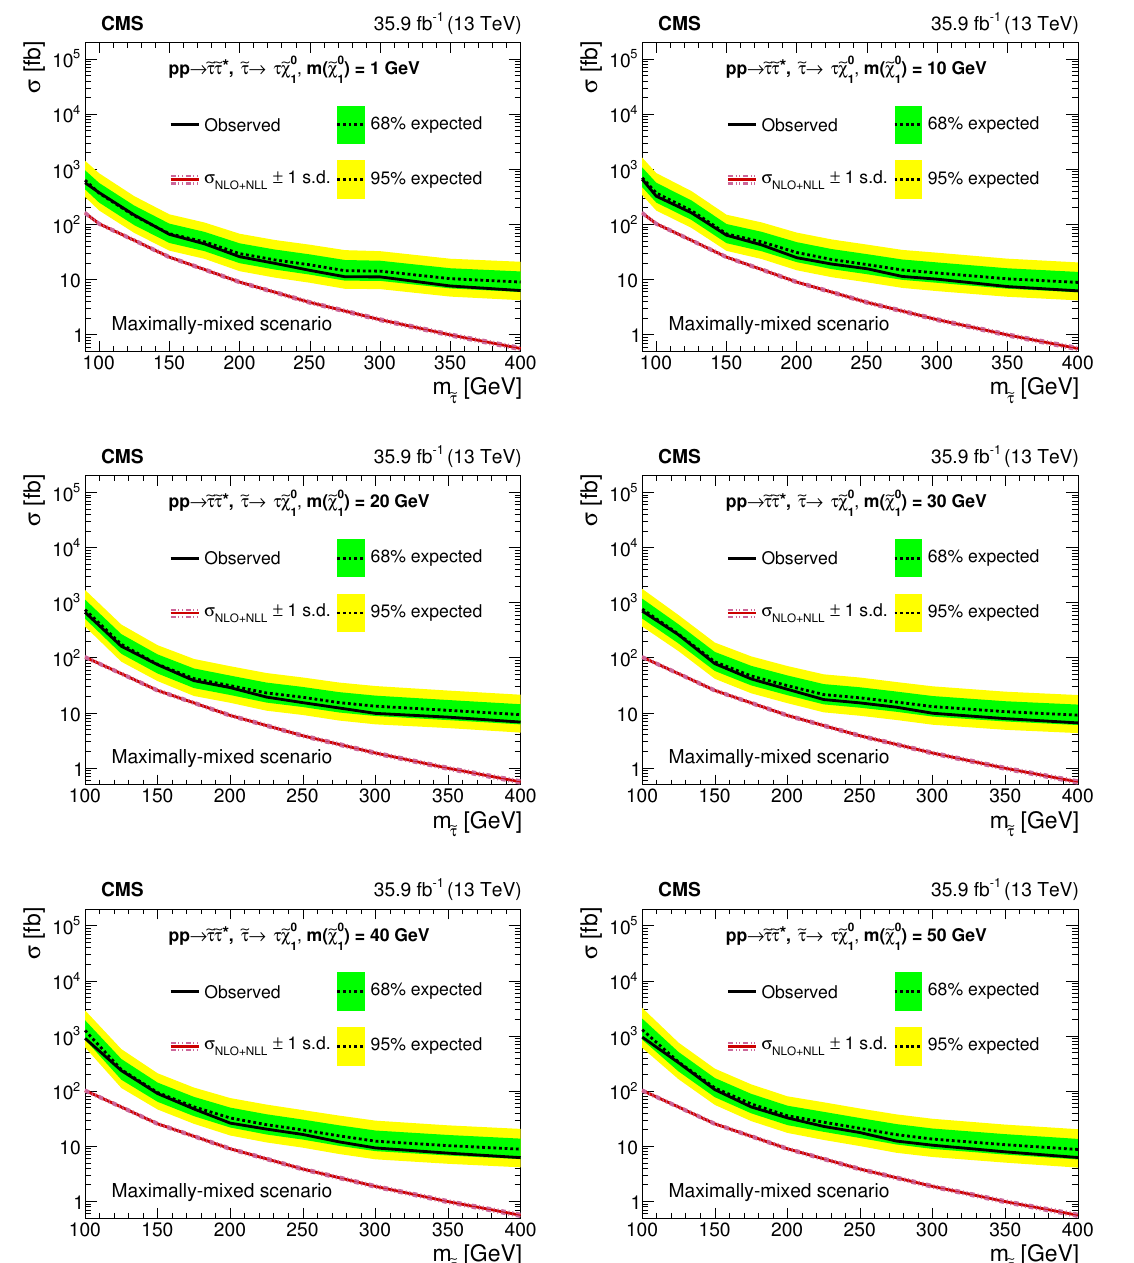
Figure 12. Excluded (cid:28) pair production cross section as a function of the (cid:28) mass for the maximally- mixed (cid:28) scenario, and for di(cid:11)erent (cid:31) 0 masses of 1, 10, 20, 30, 40, and 50 GeV from upper left to 1 lower right, respectively. The inner (green) band and the outer (yellow) band indicate the regions e e containing 68 and 95%, respectively, of the distribution of limits expected under the background- e e only hypothesis. The red line indicates the NLO+NLL prediction for the signal production cross section calculated with Resummino [47], while the red hatched band represents the uncertainty in the prediction.